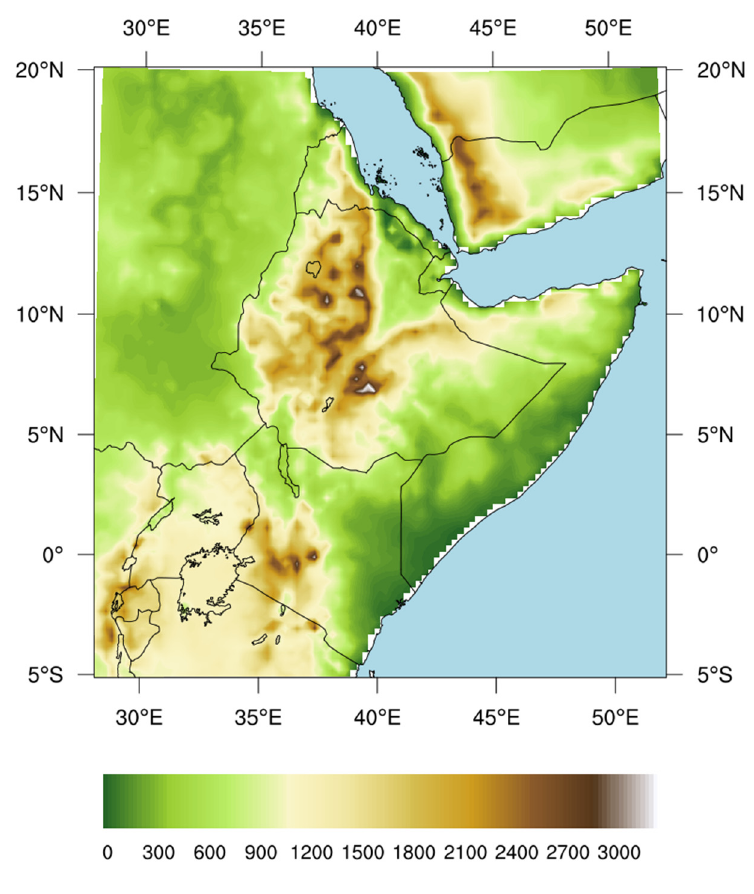
Figure 1. EA region and elevation map (m) .